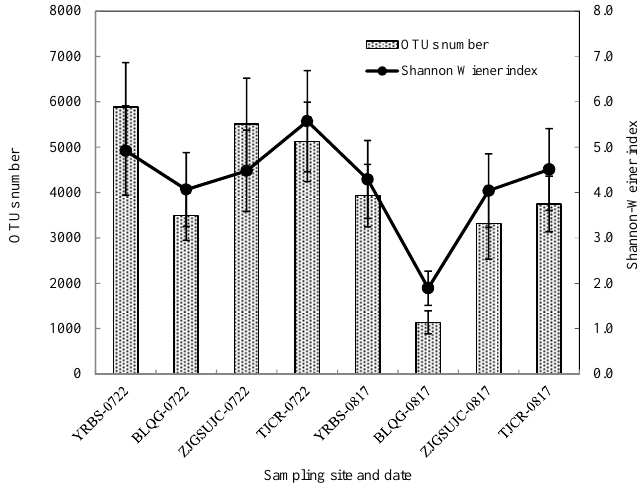
Figure 3. OTUs and Shannon–Wiener index of airborne bacteria before and after heat events.